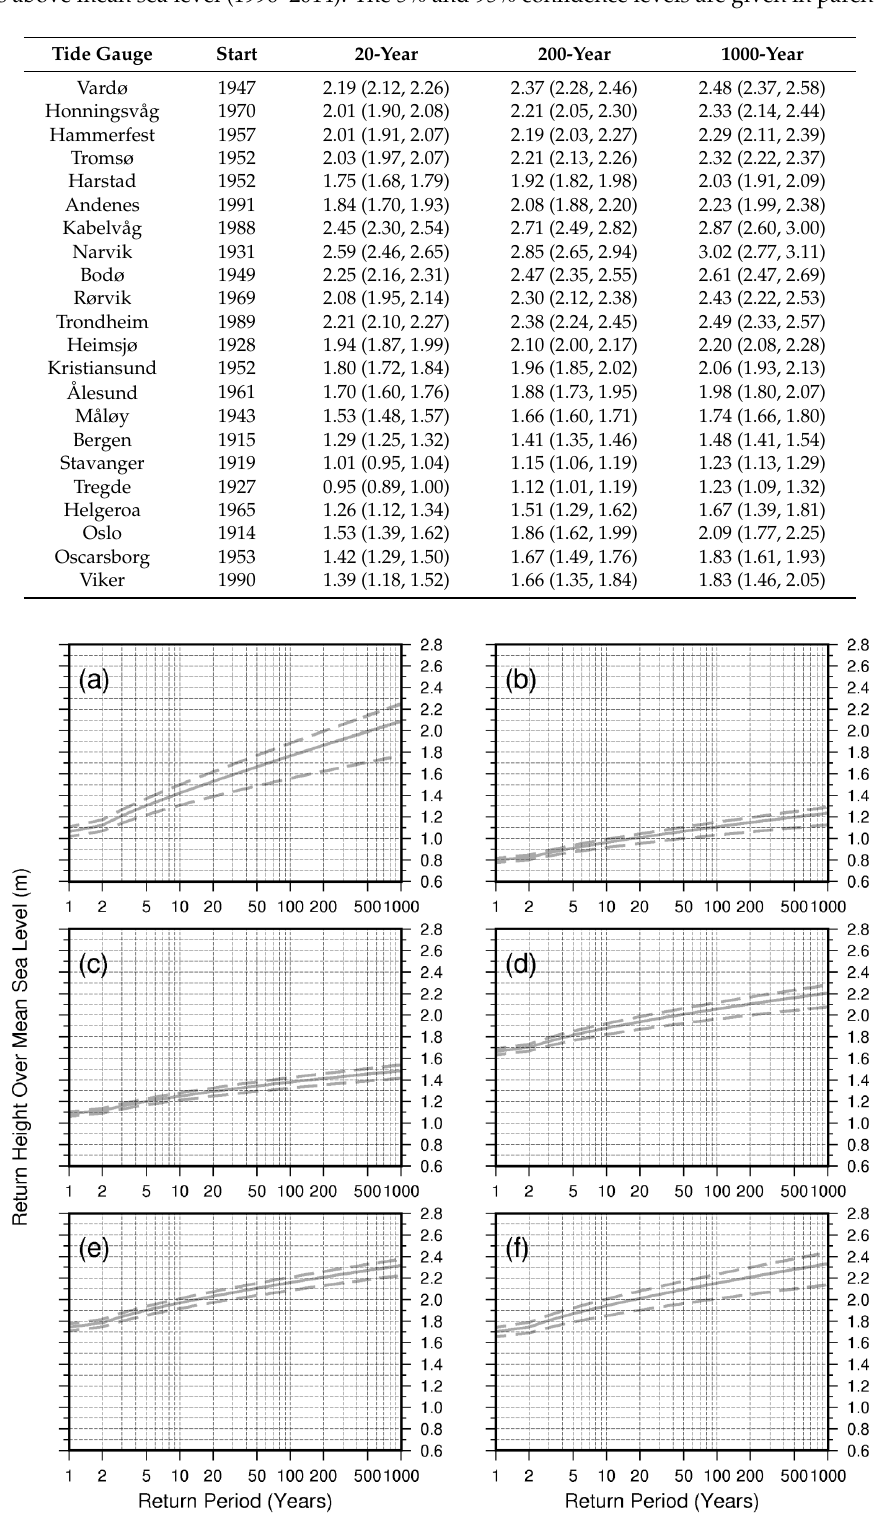
Figure 3. Return heights for extreme sea levels for the six key locations: ( a ) Oslo; ( b ) Stavanger; ( c ) Bergen; ( d ) Heimsjø; ( e ) Tromsø; and ( f ) Honningsvåg. Dashed lines are the 5% and 95% confidence intervals.